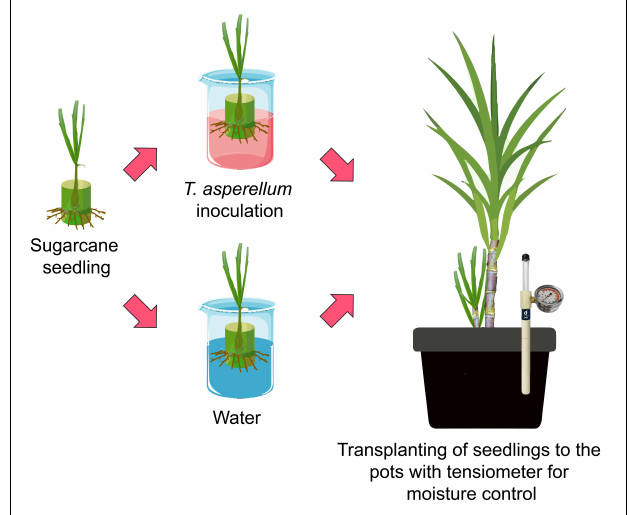
FIGURE 1 | Schematic figure representing the experiment